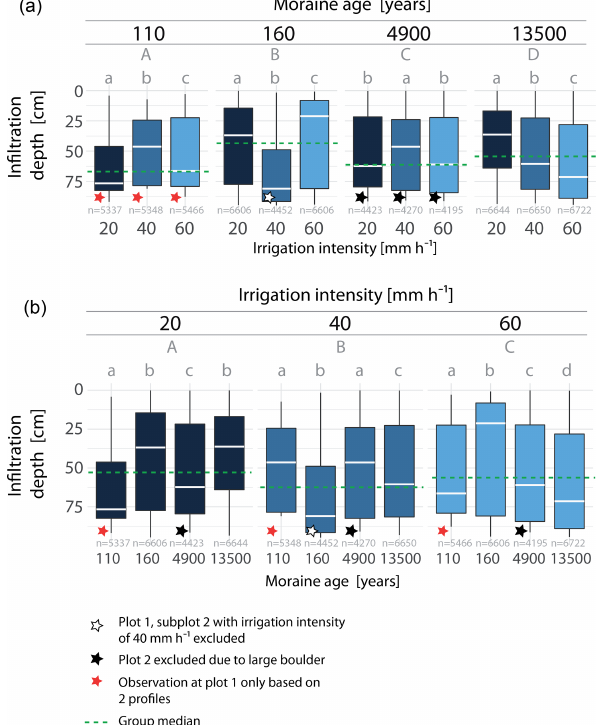
Figure 3. Maximum staining depth in each pixel column along the profile width at all excavated profiles at each age class (a) and ir- rigation intensity (b) . Median values indicate the representative in- filtration depth. Significant differences in median values are indi- cated by different letters. Upper case letters indicate the results of the Mood’s median test in combination with a post hoc test among the age classes (upper plot) and irrigation intensities (lower plot). The dashed green line shows the group median used for the test. Different lower case letters denote the results among the irrigation intensity in each age class (upper plot) and the results among the age classes at each irrigation intensity (lower plot); n equals the number of pixel columns evaluated in each box